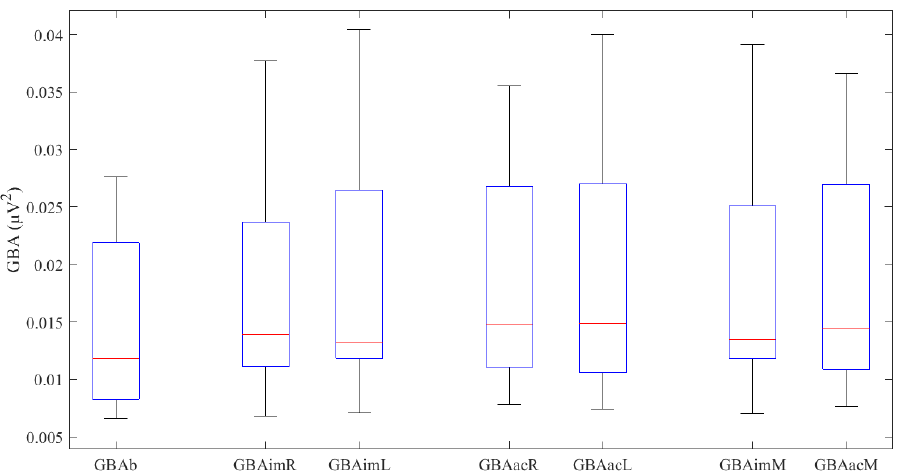
Figure 1. GBA values ( µ V 2 ) obtained in the various experiments. The upper and lower box ends denote the first and third quartiles; the red line represents the median, and the whiskers represent 1.5 × interquartile range. Table 2. Analysis of the GBA data obtained.